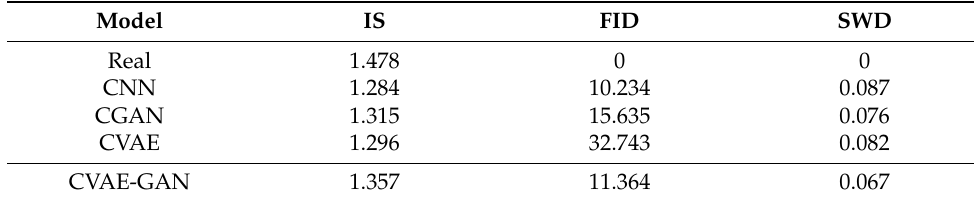
Figure 5. The average of the real and the generated samples from different subjects. Table 3. Evaluation metrics for different generation